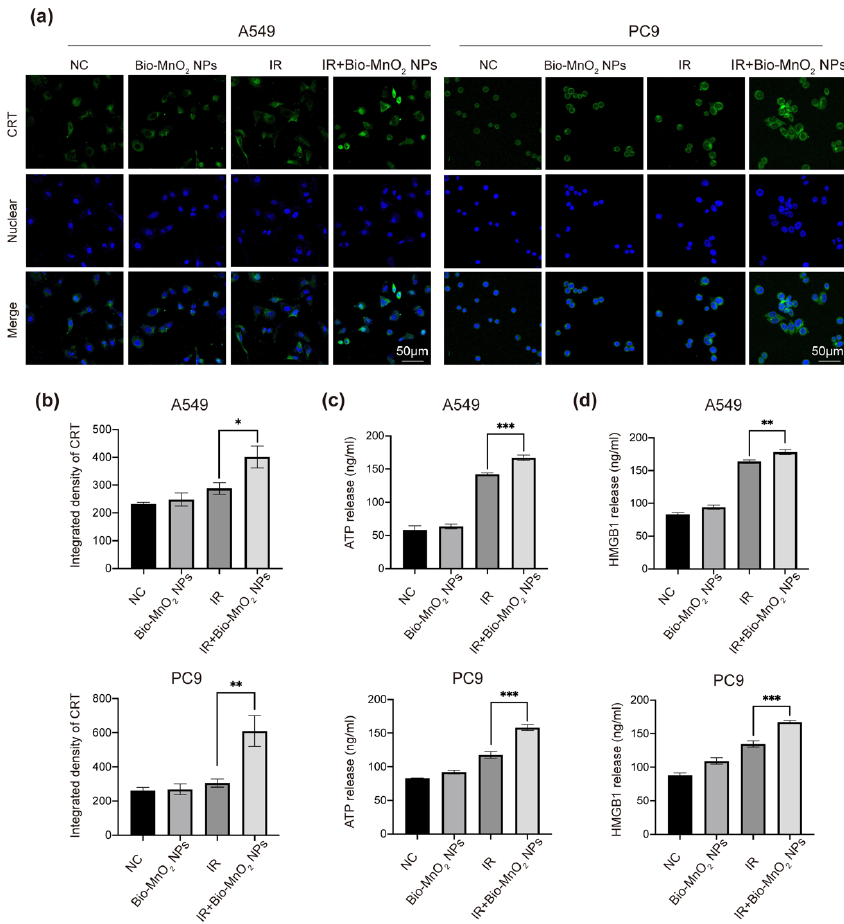
Figure 6. Bio-MnO 2 NPs plus radiation induced immunogenic cell death (ICD). ( a , b ) Representative images and statistical graphs of calreticulin (CRT) immunofluorescence (green) in different groups. Scale bar, 50 μm. ( c ) The secretion of ATP detected by ELISA after different treatments in NSCLC cells. ( d ) The secretion of high-mobility group box 1(HMGB1) detected by ELISA. *, p < 0.05; **, p < 0.01; ***, p < 0.001.